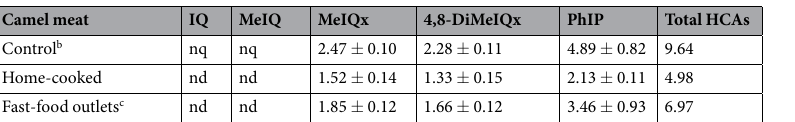
Table 2. Levels of HCAs a (ng/g ± SD) in cooked camel meat burgers. a Mean of HCAs; SD: standard deviation attained from standard addition calibration curve; b meat cooked without food additives; nq: below quantification limit; nd: not detected; c sequence analysis data of fast-food outlets samples have been provided in the supplementary